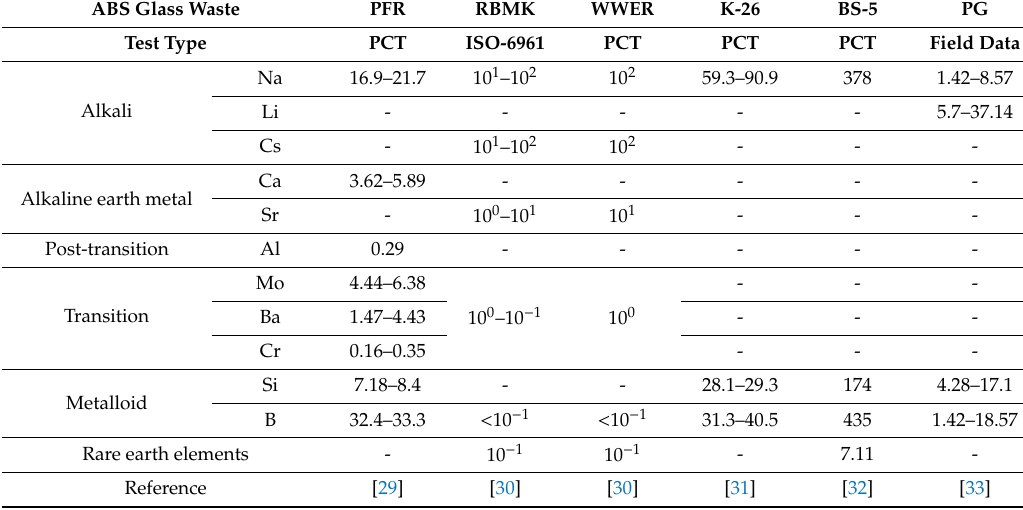
Table 1. The normalized release rate (mg · m − 2 · d − 1 ) of di ff erent elements from di ff erent alkali-borosilicate